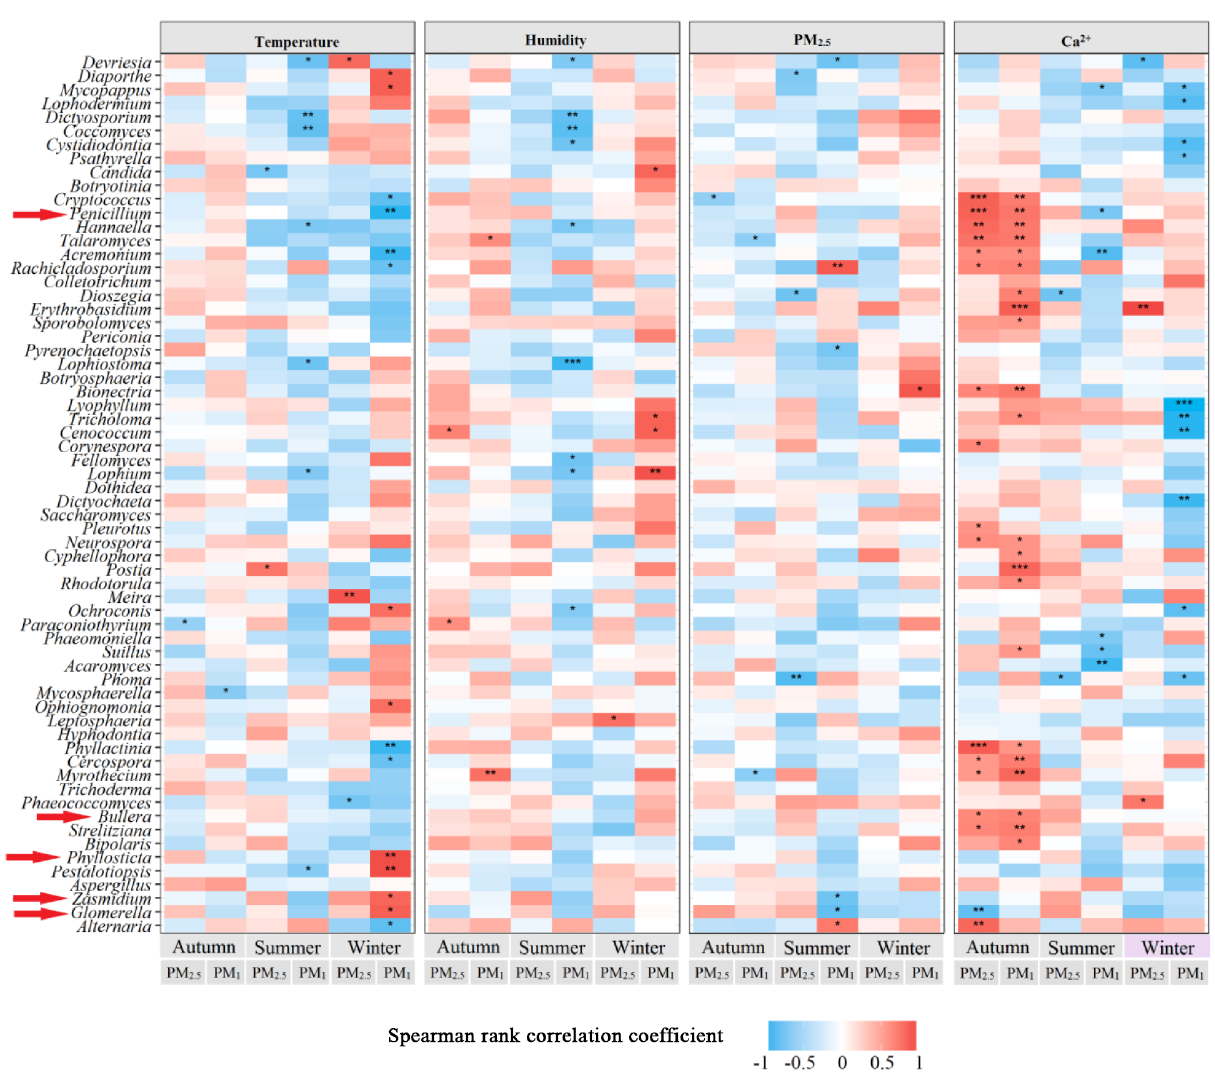
Figure 5. Heatmap analysis of the top 64 fungal genera based on Spearman’s rank correlations ( ∗∗∗ p <0.001; ∗∗ p <0.01; ∗ p <0.05). Red arrows indicate that the specific fungi varied significantly in different